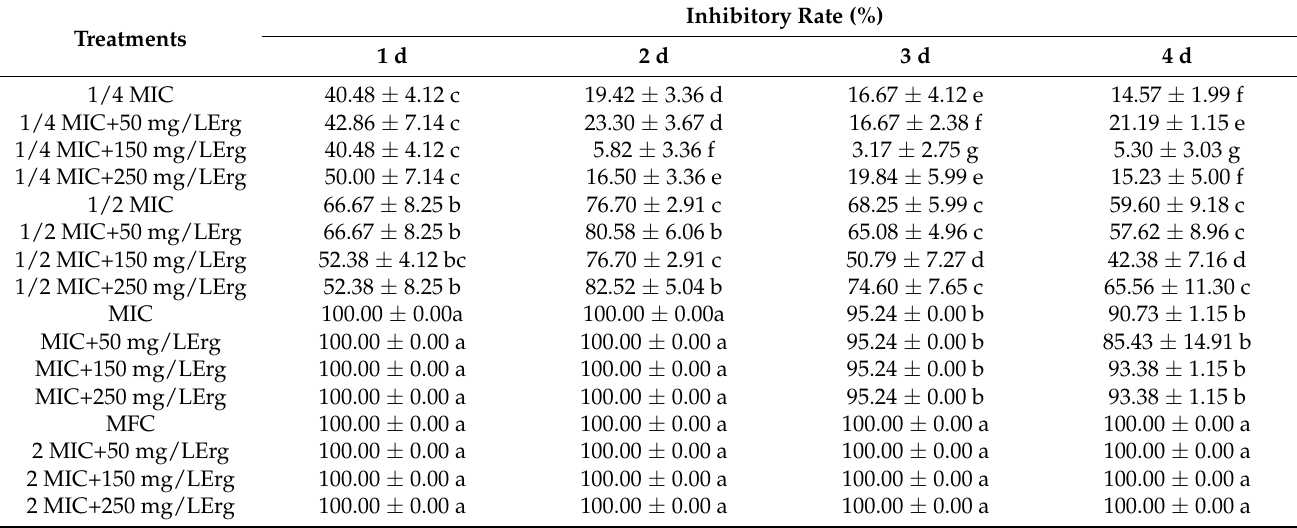
Table 2. Effects of citronellal and exogenous ergosterol on the growth of P. digitatum .